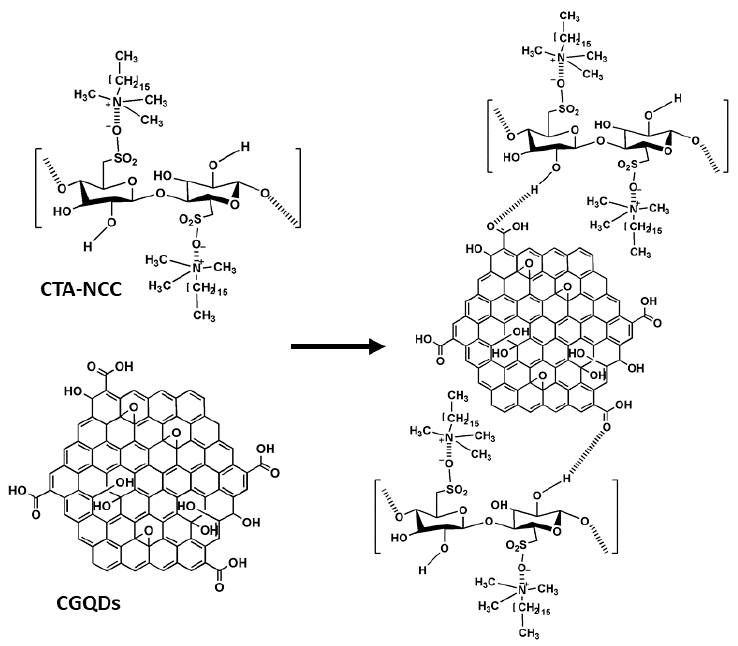
/ CGQD nanocomposite.